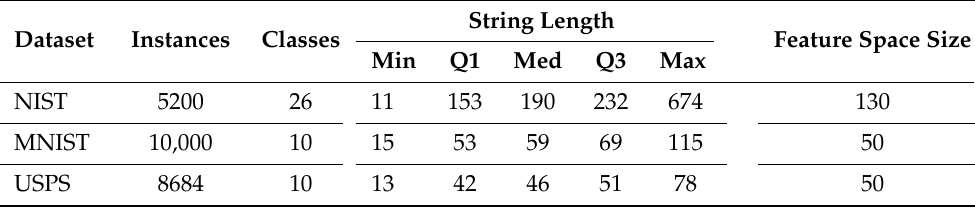
Table 1. Description of the data collections considered in terms of number of instances, classes, and sample sizes in both the initial string and the Dissimilarity Space (feature-based) one using RandomC. Min , Med , and Max stand for the minimum, median, and maximum datum length while Q1 and Q3 denote the first and third quartiles,